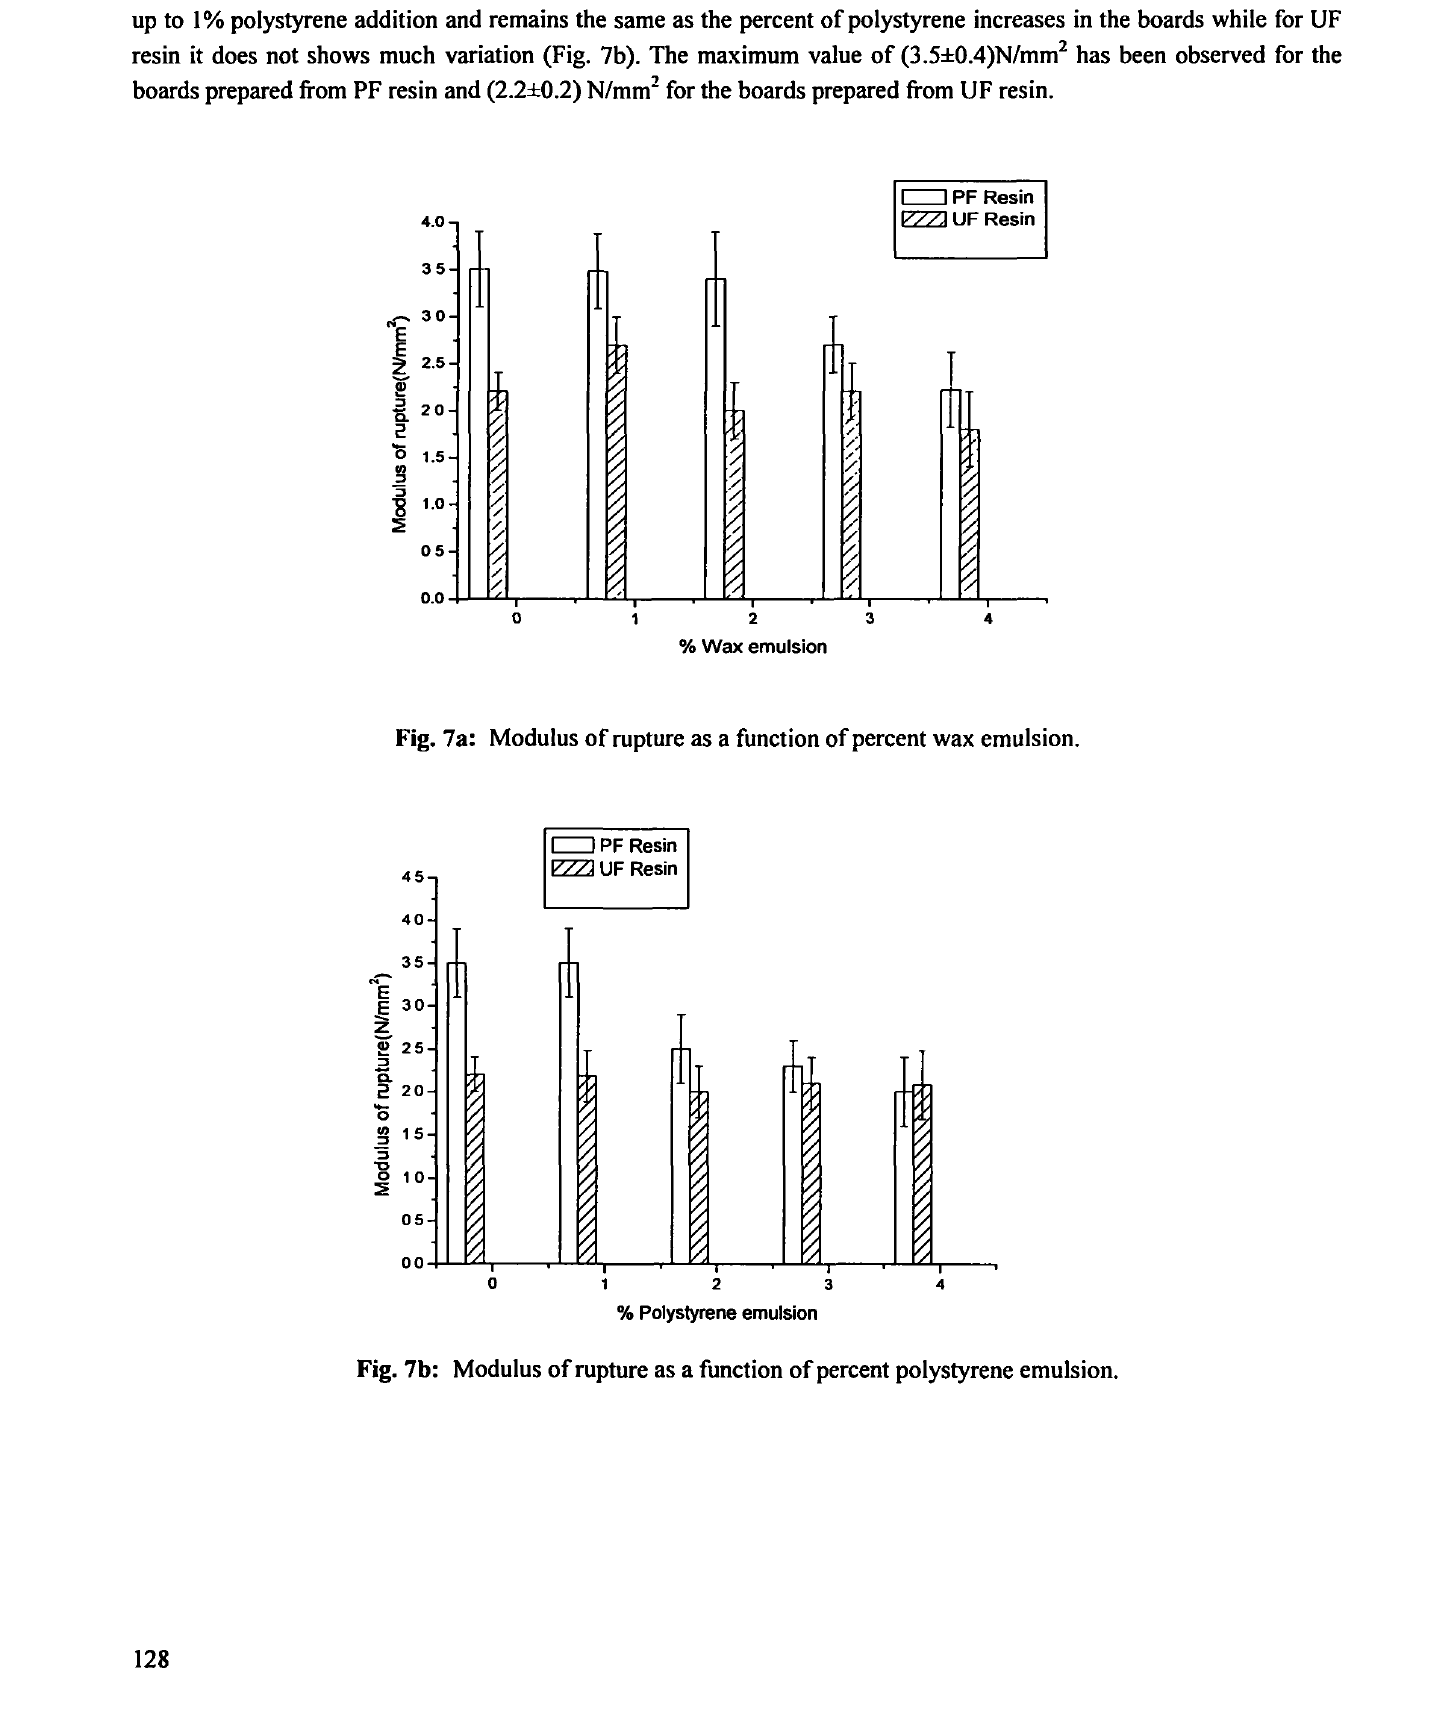
Fig. 7b: Modulus of rupture as a function of percent polystyrene